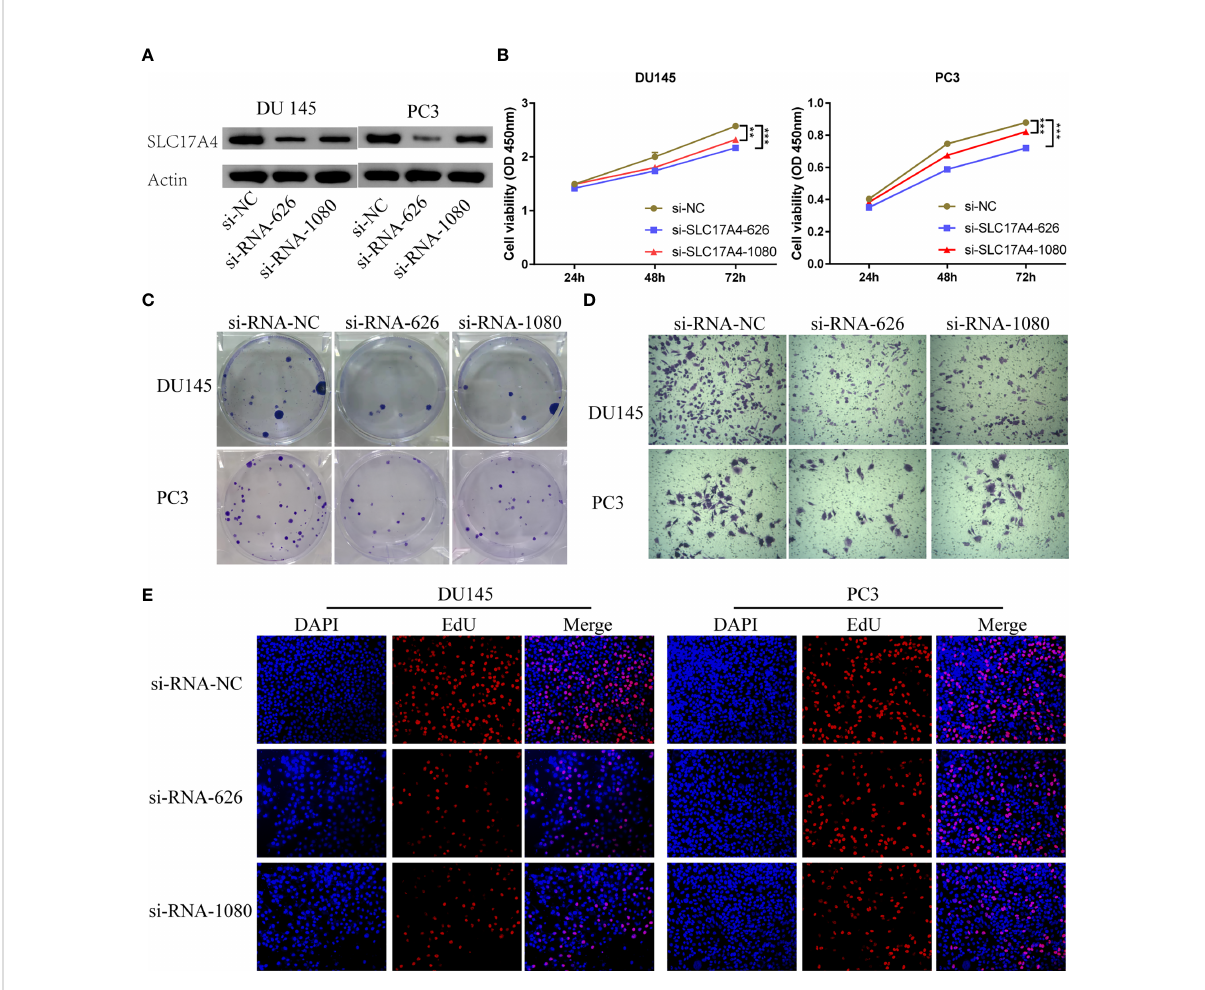
FIGURE 12 (A) Measurement of siRNA transfection ef fi ciency in DU145 and PC3 cells at the protein level. (B) CCK-8 assays revealed that silence of SLC17A4 suppressed the proliferation of DU145 and PC3 cells. (C) Colony formation assay of DU145 and PC3 cells after the knockdown of SLC17A4. (D) Knock-down of SLC17A4 affected the invasion ability of DU145 cells and PC3 cells (Crystal Violet Staining). (E) EdU assay of PC3 and DU145 cells after the knockdown of SLC17A4 (siRNA-NC: siRNA negative control). **p < 0.01, ***p <